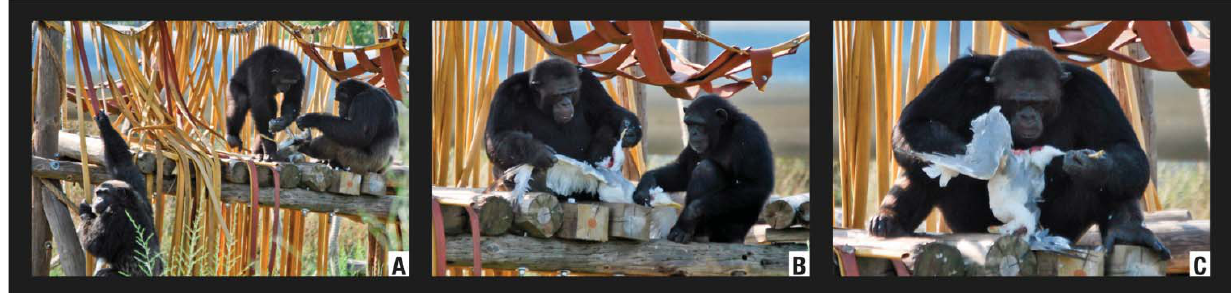
Figure 4. Predation of a Larus michahellis (Episode H3) by Male Group.